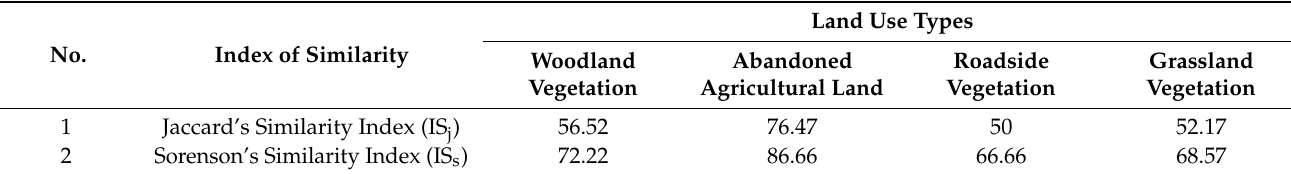
Table 2. Similarity indices in Parthenium invaded and non-invaded areas.